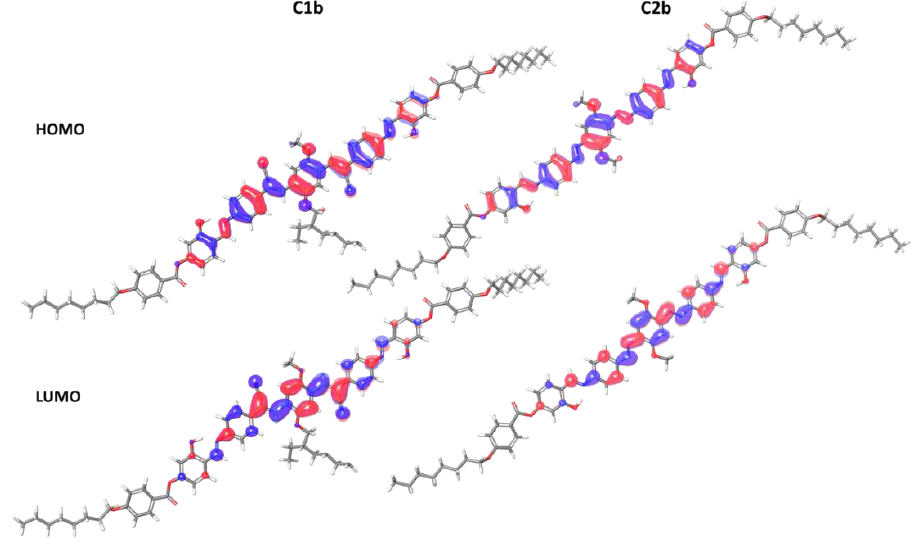
Figure 4. Representation of HOMO and LUMO orbitals for C1b and C2b. Table 3. Electro-optical properties calculated on C1b and